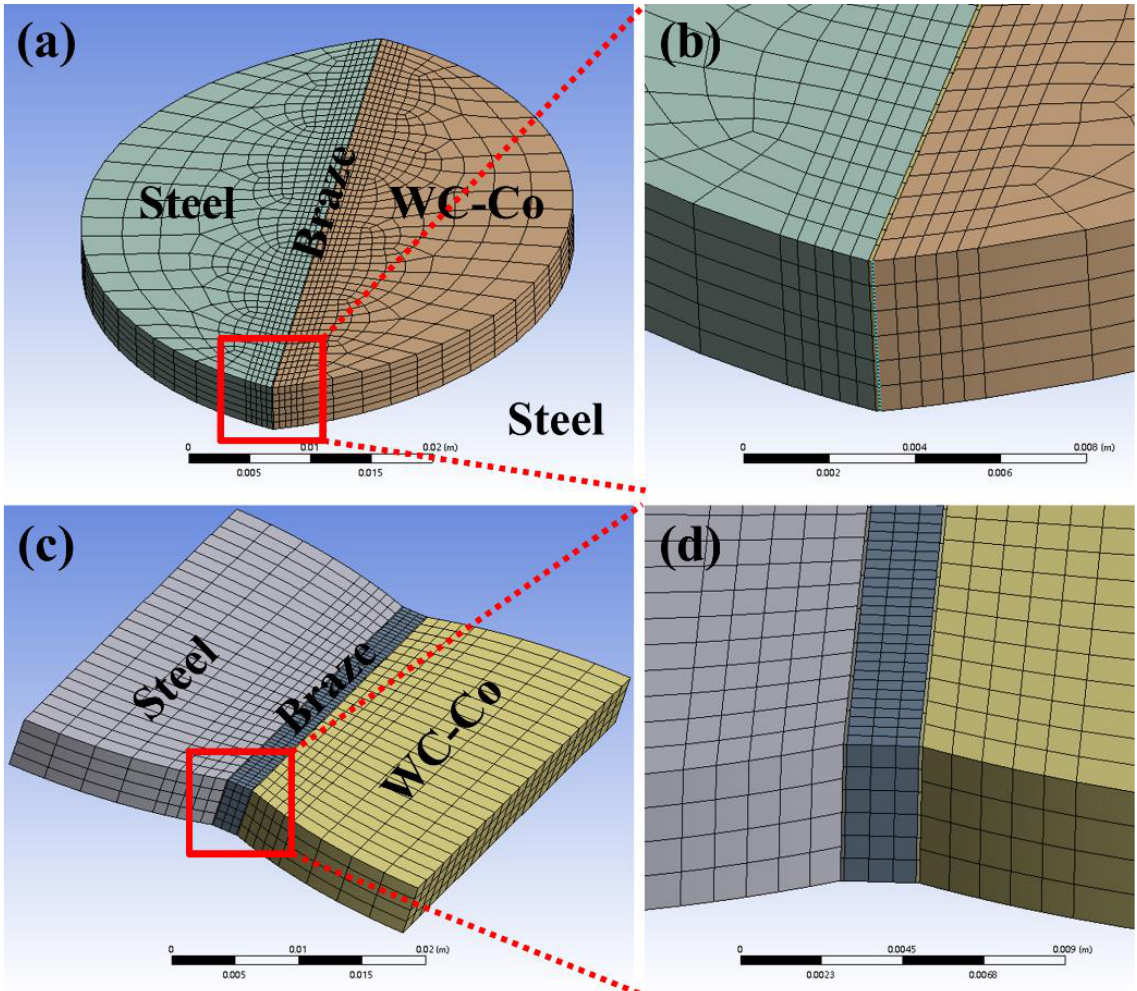
Figure 2. Meshing of finite element model, ( a , b ): single-layer brazing model, ( c , d ): three-layer braz- ing model.